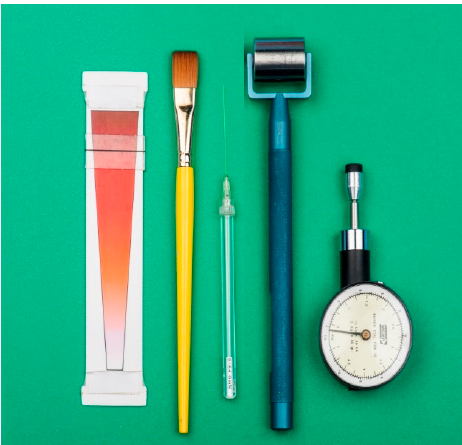
Figure 1. The test instruments summarised in Table 2: Coloured Analogue Scale, Camel hair brush, von Frey optical glass filament No 12, ThermoRoll (at 22 °C), Fischer Handheld Pressure Algometer. The sources are in Supplementary Table S3.